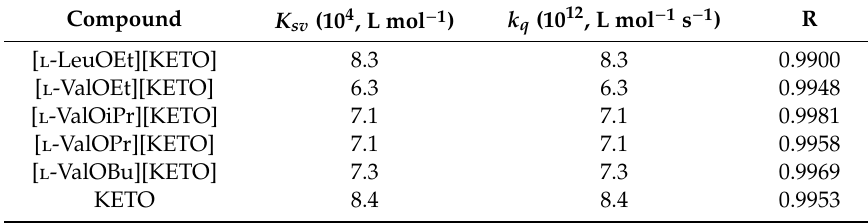
Figure 1. Change in the fluorescence emission spectra of BSA in the presence of various concentration of ketoprofen ( a ); [ l -LeuOEt][KETO] ( b ); [ l -ValOEt][KETO] ( c ); [ l -ValOiPr][KETO] ( d ) [ l -ValOPr][KETO] ( e ) and [ l -ValOBu][KETO] ( f ) in sodium phosphate bu ff er (pH 7.4, 50 mM) at 25 ◦ C. The insertions represent the Stern–Volmer plot. Table 3. Stern–Volmer quenching constants ( K sv ) and bimolecular quenching rate constant ( K q ) of binding of ketoprofen and the ketoprofen-based ILs with BSA at 25 ◦ C.